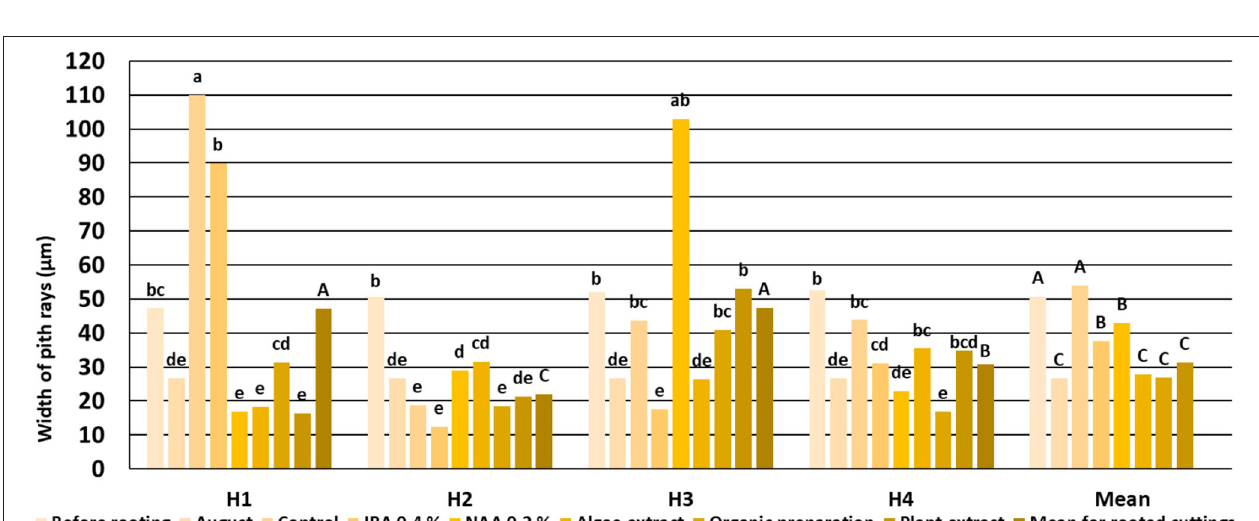
FIGURE 4 | (10ml) after planting; Plant extract—watering with 0.02% Bio Roots (10ml) after planting. H1 − 54 504 (flower buds still closed); H2 − 69 605 (full flowering; at least 50% of flowers open); H3 − 69 629 (end of flowering of the second-order stem—all petals have fallen); H4 − 70 701 [fruit set: beginning of hip (berry) growth on